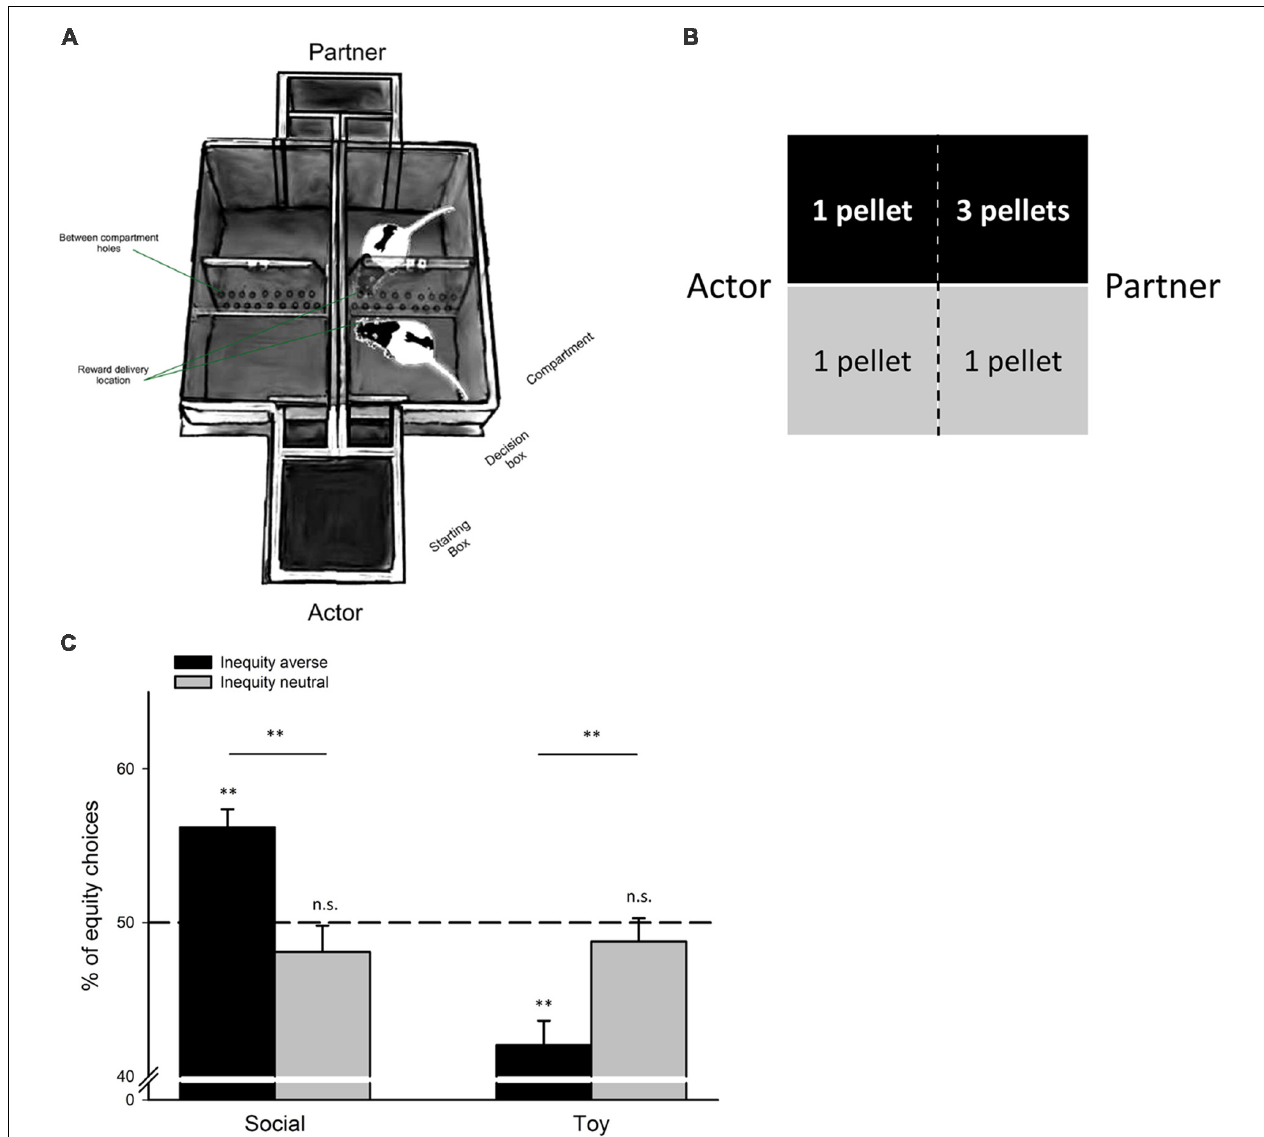
FIGURE 1 | Choice-based disadvantageous inequity aversion task for rats. (A) Double T-maze apparatus for quantifying disadvantageous IA in rats. Pairs of rats are trained in this task. The actor rat chooses to enter either an equal-reward compartment, or an unequal-reward compartment. The partner is always directed towards the opposite compartment facing the actor. Actor’s and partner’s compartments are separated by a transparent, perforated wall, allowing rats to see, hear and smell each other, but neither rat can access the other rat’s compartment. The actor rat selects the reward distribution for both rats by entering one of the two compartments in each trial: entering the equal reward compartment produces one food pellet for each rat, entering the unequal-reward compartment yields one food pellet for the actor rat, and three food pellets for the partner rat. Thus, the actor’s decisions are non-costly because its own-payoff is always identical and independent of its choice, but it can choose between a fair outcome (both rats receive the same reward magnitude), or an unfair outcome (the partner rat receives a higher reward than the actor rat). In a non-social control condition (the toy condition), reward contingencies, payoff matrix and all other features of the task are identical, but the partner rat is replaced by an inanimate toy rat. Adapted from Hernandez-Lallement et al. (2015, 2016) with friendly permission by Frontiers in Neuroscience, (B) illustration of the payoff matrix, (C) rats were classified as inequity averse, or inequity neutral, depending on their individual sensitivity to unequal reward distributions (see Oberliessen et al., 2016 for details). Unlike inequity-neutral rats, inequity-averse rats preferred equal over unequal outcomes in the social, but not in the non-social control condition, the toy condition ( ∗∗ p < 0.01; n.s., not significant). Adapted from Oberliessen et al. (2016) with friendly permission by Elsevier.